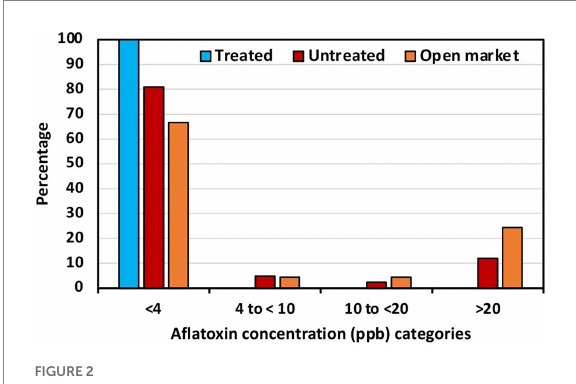
FIGURE 2 Percentage of maize from biocontrol treated fields, untreated fields, and open market in each of four total aflatoxin concentration